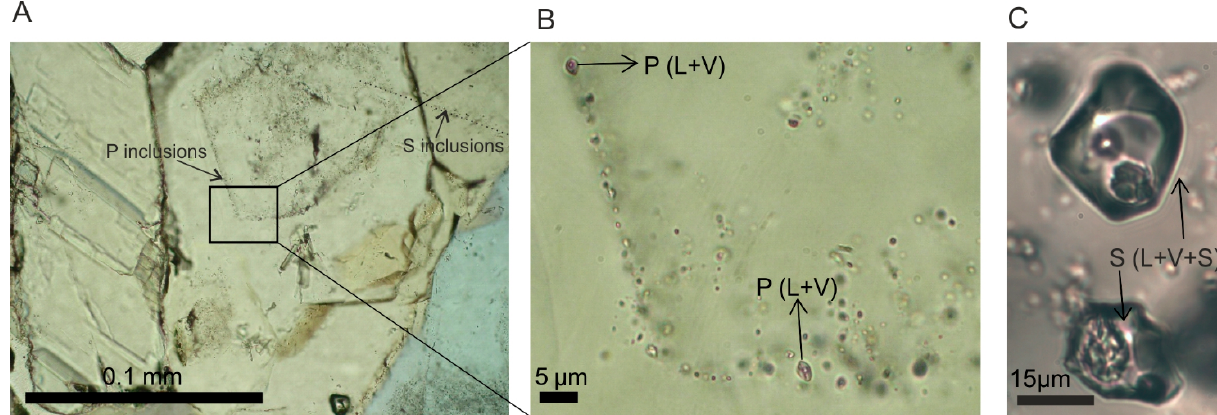
Figure 8. Fluid inclusions in the studied samples. ( A , B ) primary, liquid + vapor fluid inclusions in a growth zone of an early quartz grain (Qtz 1). Secondary trails cross-cut the crystal boundaries (Campegli). ( C ) Large liquid + vapor + solid secondary fluid inclusions in an early quartz grain (Qtz 1) (Vigonzano). The solid phase is an accidentally trapped sericite grain (determined by Raman spectroscopic analyses).